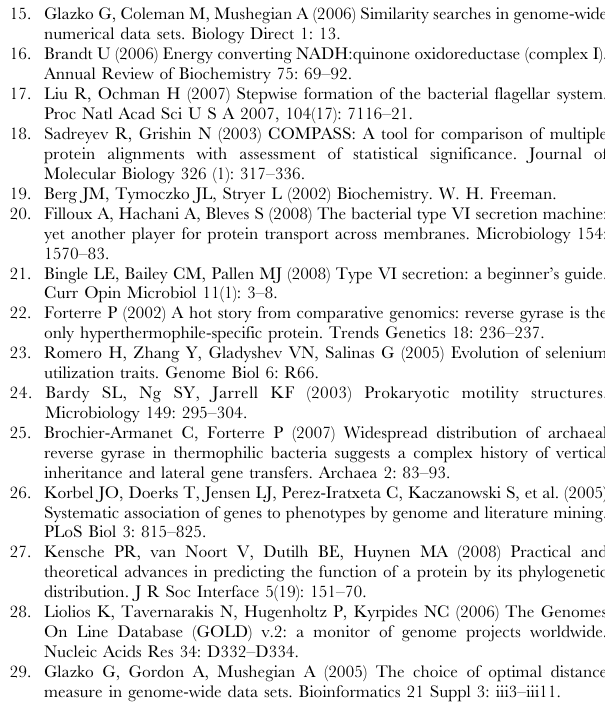
Table S6 The list of genomes in the COG-06 dataset.